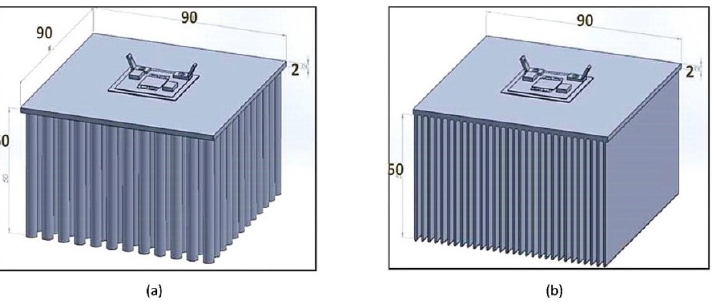
Figure 7. Round pins heat sink ( a ) and Straight fins heat sink ( b ) [72].